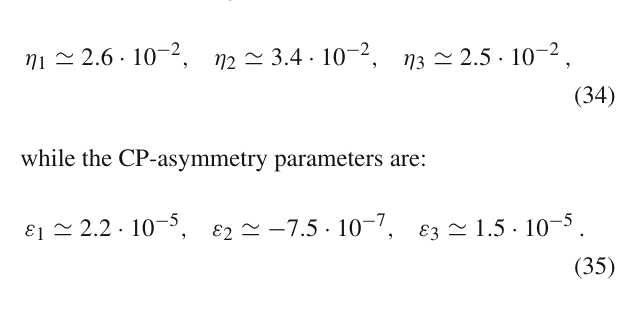
Table 3, the efficiency factors turn to